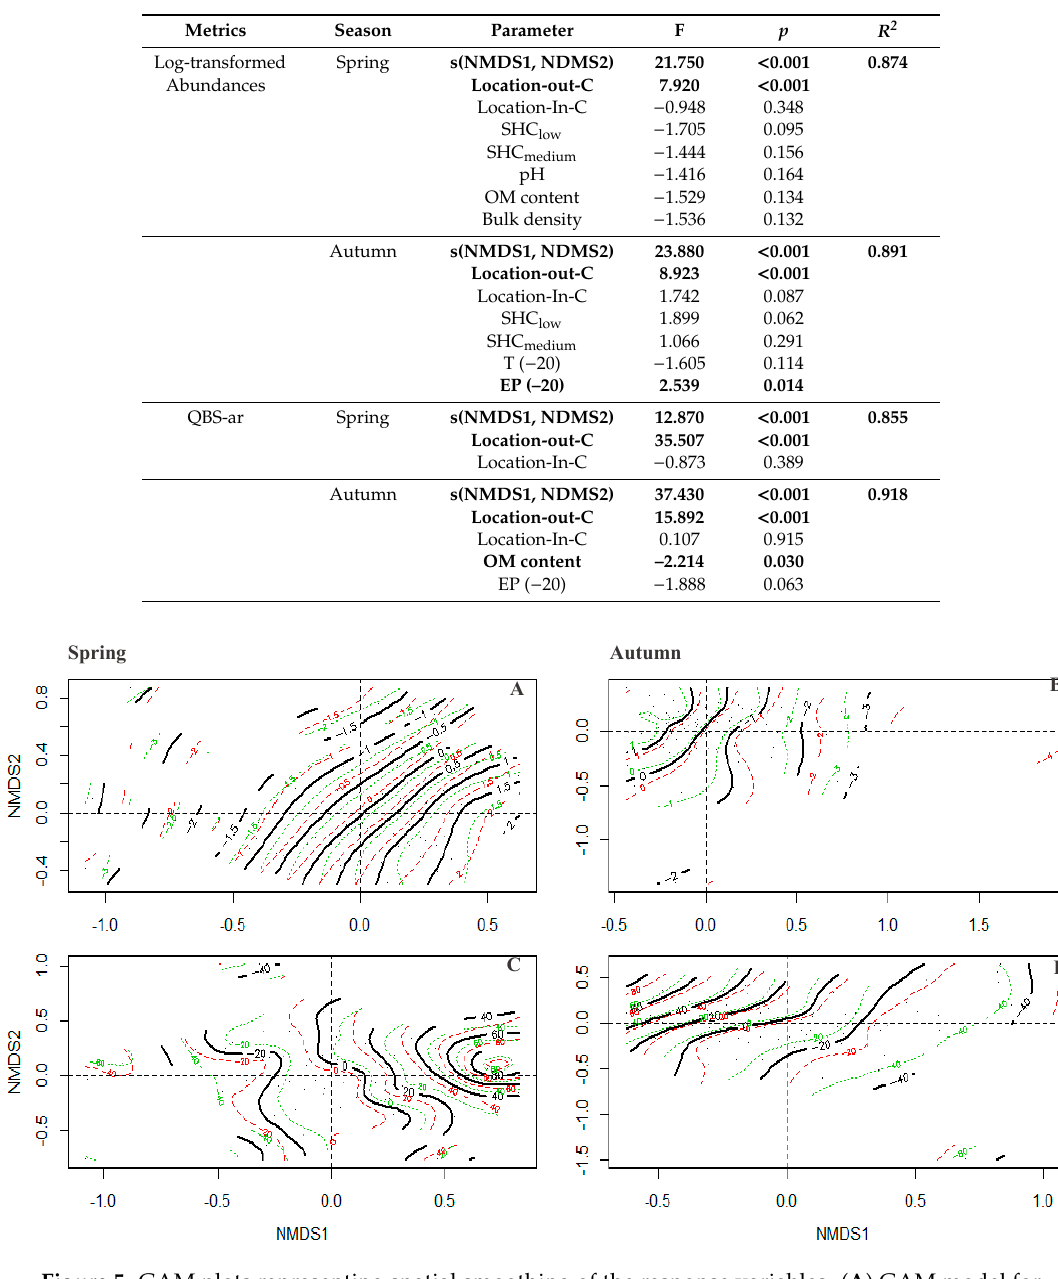
Figure 5. GAM plots representing spatial smoothing of the response variables. ( A ) GAM model for spring total abundances; ( B ) GAM model for autumn total abundances; ( C ) GAM model for spring QBS-ar; ( D ) GAM model for autumn QBS-ar. Codes represent the quantity by which each response variable varies. Black-solid isolines represent the spatial smoothing that belonged to a determined interval of variation. Red-dashed isolines represent the upper variation of that interval associated with each black solid isoline sharing the same code. Green-dashed isolines represent the lower variation of that interval associated to each black solid isoline sharing the same code.